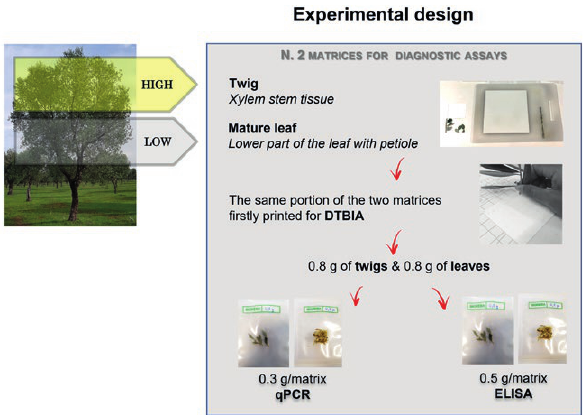
Figure 1. The experimental design used for sampling olive trees. This shows the two canopy levels that were sampled (four semi-hardwood twigs with mature leaves were collected from each level), and the analyses for detection of Xylella fastidiosa using two matrices: the stem xylem tissue and the lower part of the mature leaves with their petioles. Each host matrix was first printed on nitrocellulose mem- brane for DTBIA and was then used for qPCR and